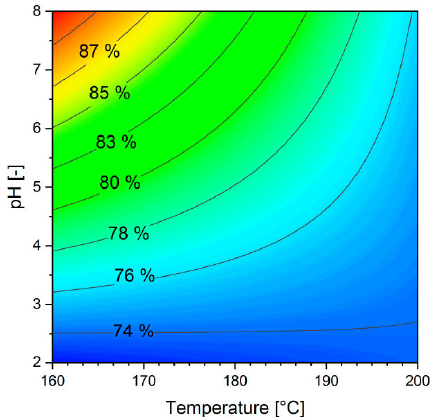
Figure 3. Regression model contour plot showing the influence of initial pH and reaction temperature on the solid yield (% db